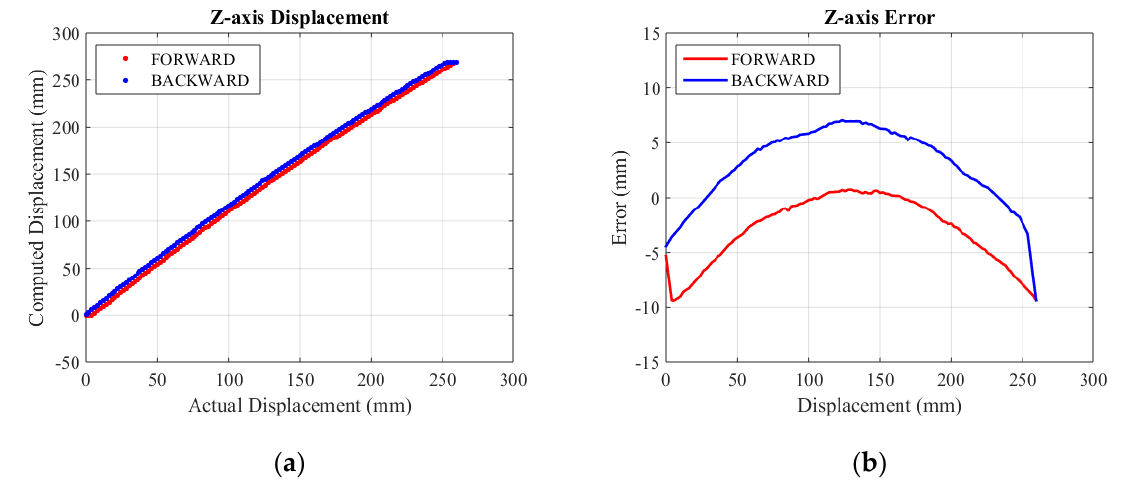
Figure 15. Z-axis displacement and error. ( a ) Displacement; ( b ) Error.